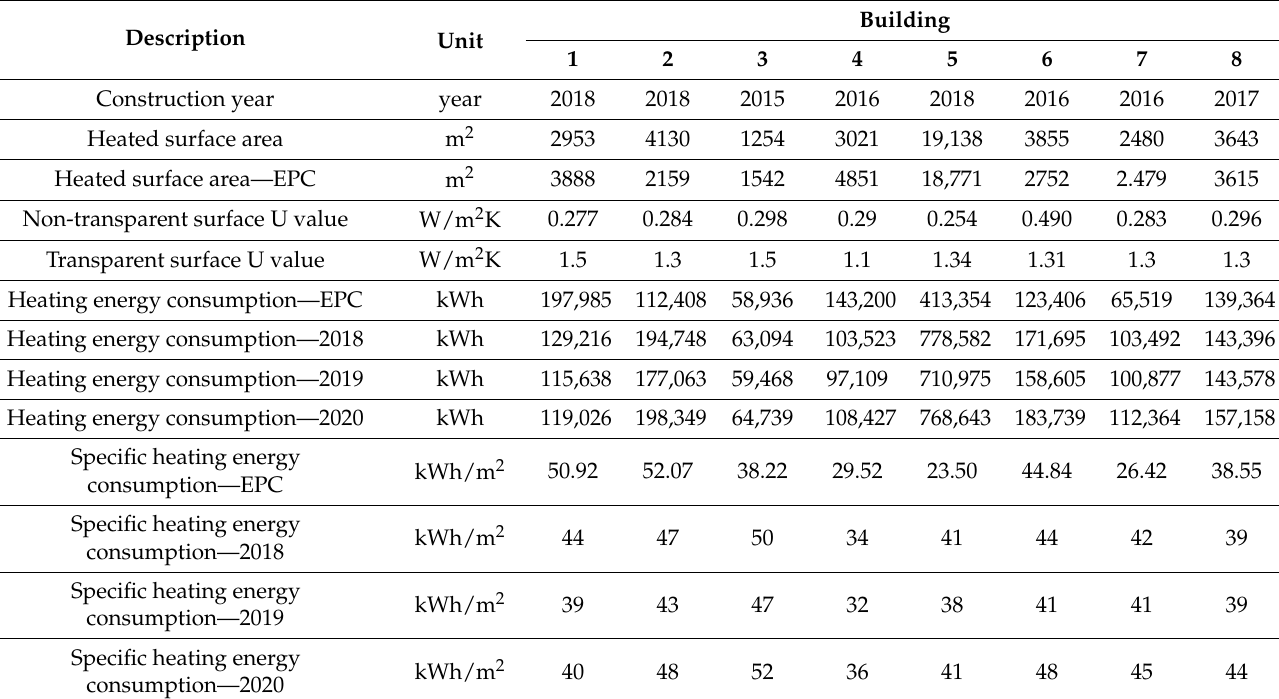
Table 3. Selected buildings connected to the District Heating